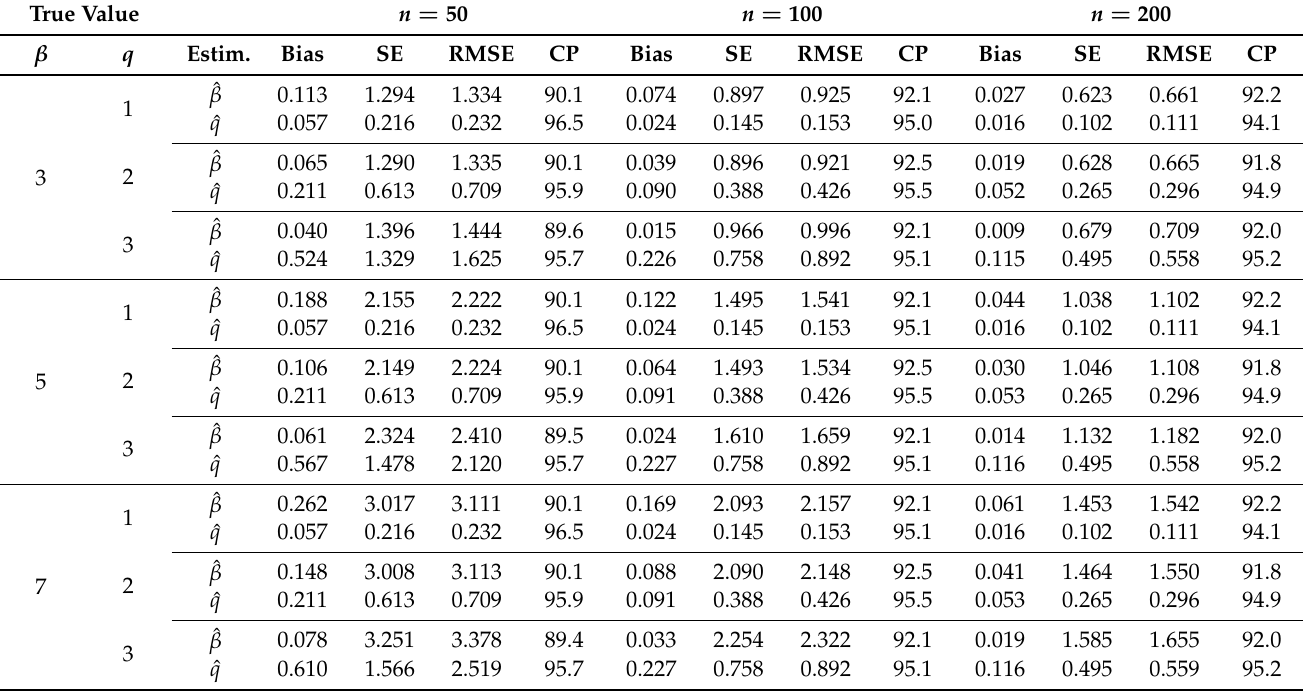
Table 2. Simulation study for different combinations of parameters for the SMMB( β , q ) model.